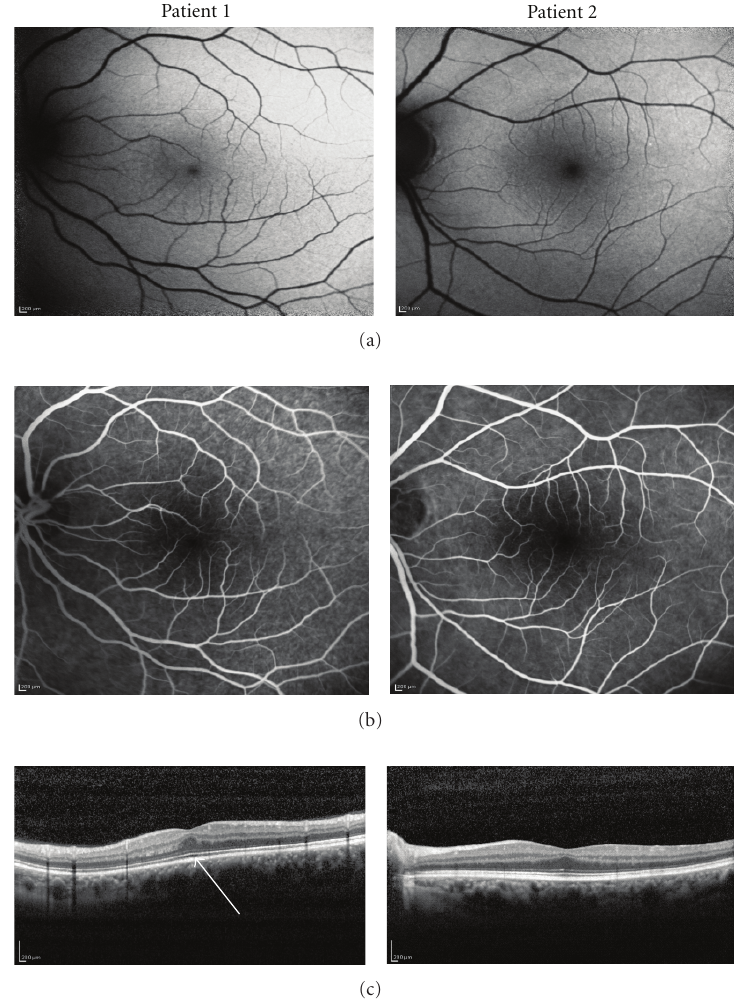
Figure 1: (a) Fundus autofluorescence imaging did not show the typical foveal darkening due to absorption of the excitation light by macular pigment in patient 1. Patient 2 had only a slightly reduced foveal attenuation of autofluorescence. (b) The foveal avascular zone was absent in the flourescein angiogram in patient 1. Patient 2 had a normal aspect in fluorescein angiography. (c) SD-OCT showed reduced foveal pit and continuity of inner retinal layers in both patients. Photoreceptor layer had a normal thickness centrally in patient 1